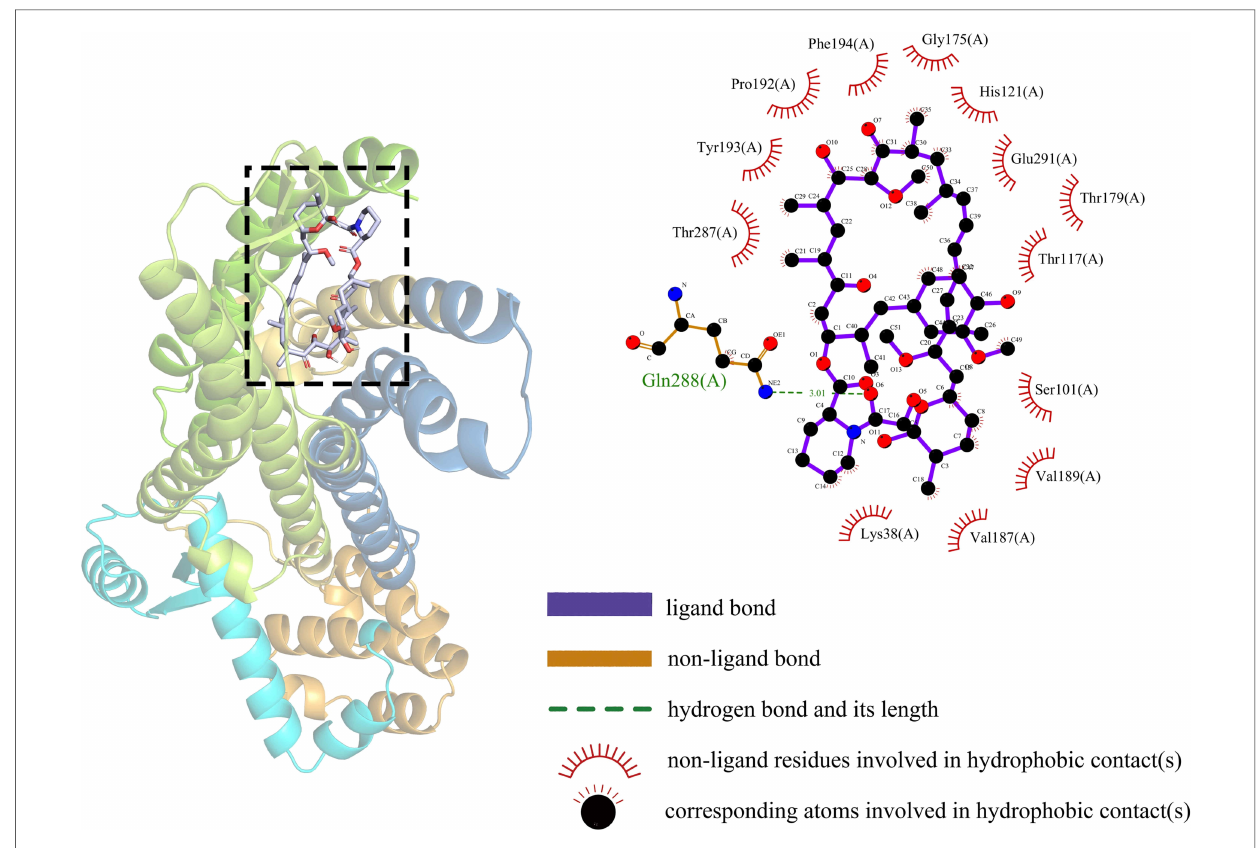
FIGURE 9 Schematic diagram of sirolimus-CCR2 molecular